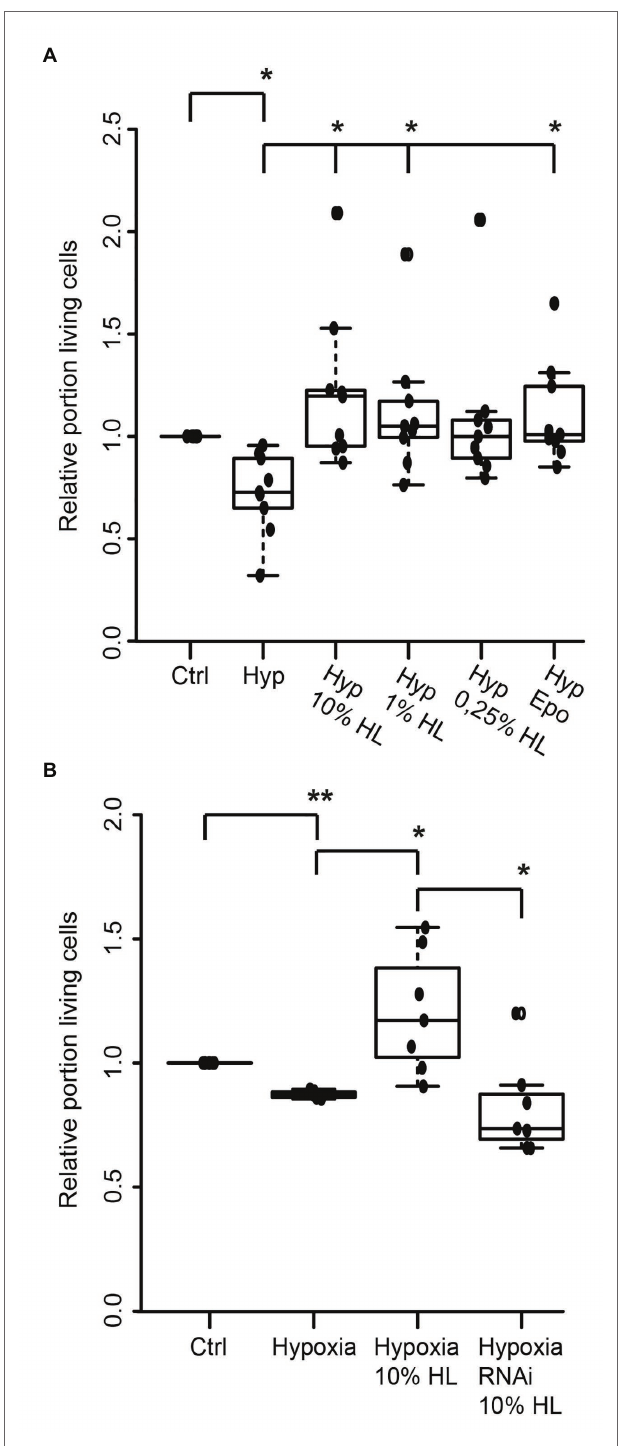
FIGURE 5 | Locust hemolymph protects Tribolium castaneum neurons from hypoxia-induced apoptosis via activation of CRLF3. (A) Hypoxia decreased the relative proportion of intact insect neurons compared to normoxic controls. Ten percent locust HL, 1% locust HL, and 3.33 ng/ml Epo prevented hypoxia-induced death of beetle neurons ( p < 0.05 compared to hypoxia control, respectively; no difference to normoxic control). About 0.25%